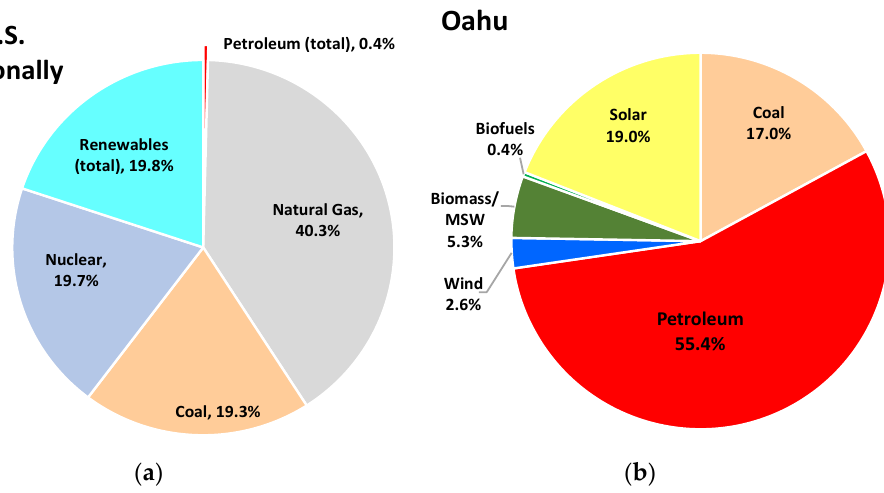
Figure 1. Electricity generation by fuel source, showing the contrast in petroleum oil as a fuel source (as a percentage of net generation in 2020): ( a ) Nationally, 0.4% of electricity was generated from oil and; ( b ) Oahu, Hawaii, 55.4% of electricity was generated from oil.